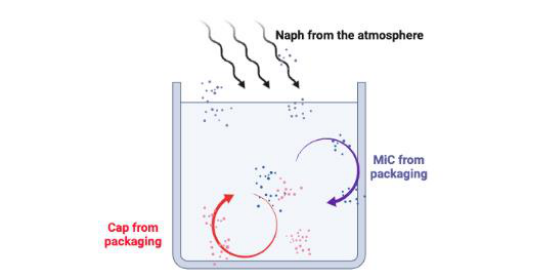
Figure 1. Migration routes of the selected SVOCs into water (created with